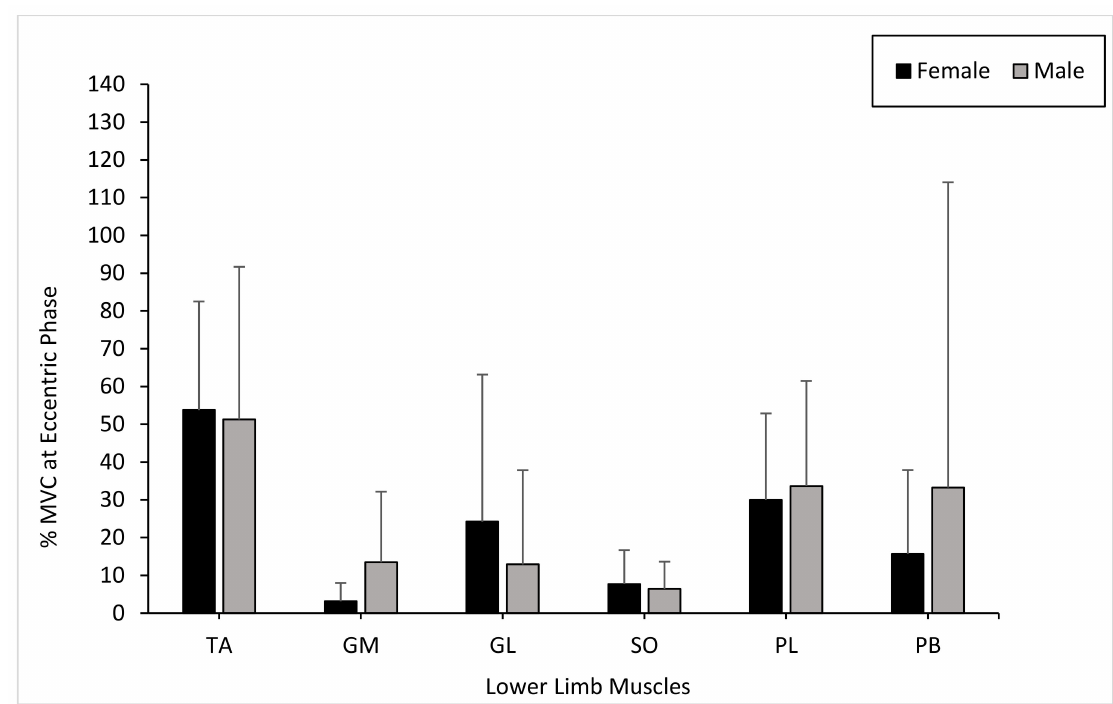
Figure 5. Mean gender differences in muscle activation (TA, GM, GL, SO, PL, and PB) within the dominant limb during the eccentric phase with error bars ( ± standard